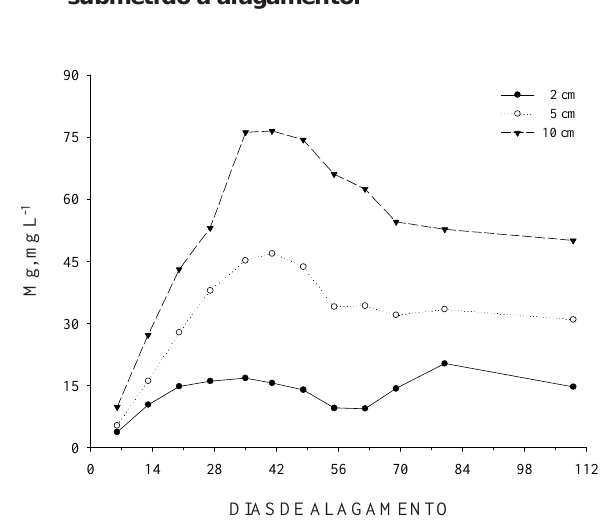
Figura 7. Concentração de potássio na solução do solo em três profundidades de um Planossolo submetido a